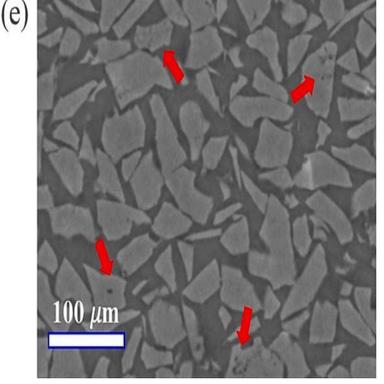
SEM and CT micrographs of the powders in the as-received state: (a) fine; (b) rounded; (c) intermediate and (d) coarse. The red arrow in (d) indicates a particle with rough surface. (e): A slice of μCT images on the coarse powder with the red arrows showing the particles with initial defects. (For interpretation of the references to colour in this figure legend, the reader is referred to the web version of this article.)